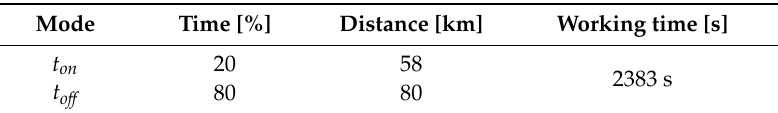
Table 7. On-o ff control Table 7. On-off control mode.